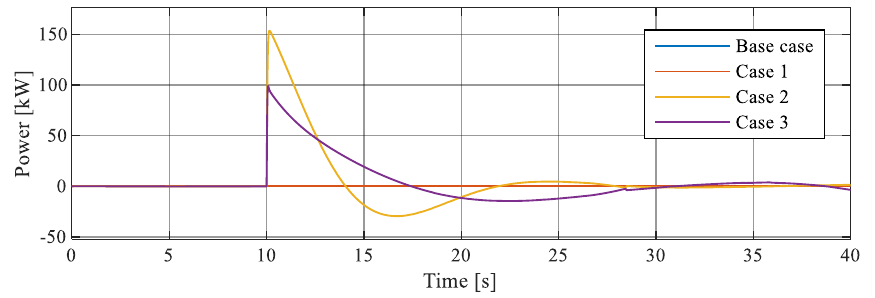
Figure 14. Active power deviation experienced by the BESS in a sub-frequency